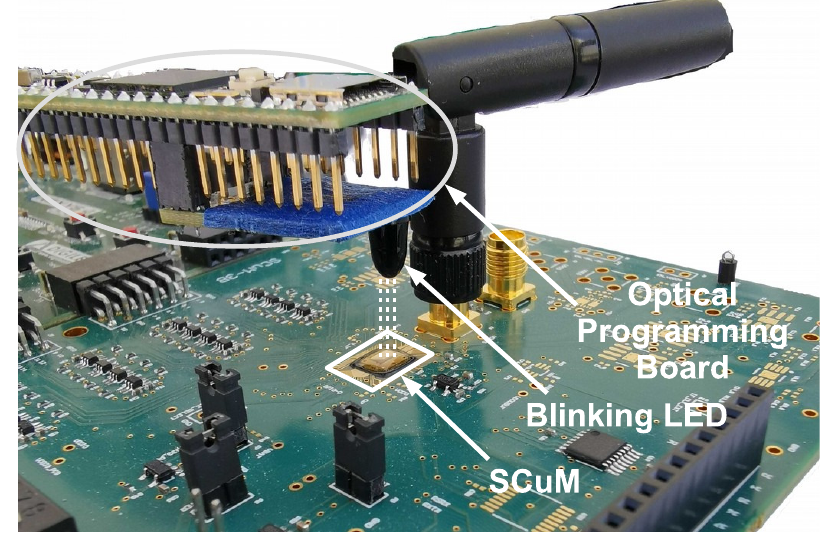
Figure 3. The blinking pattern of the LED on the optical programming board (top) is used to switch